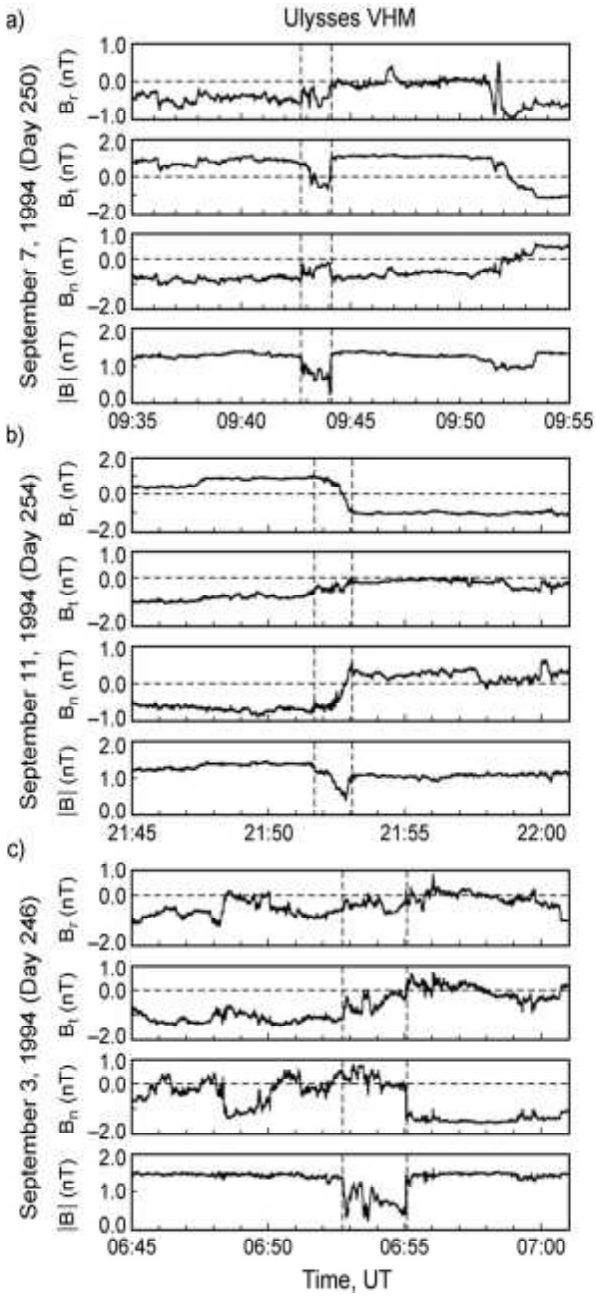
Fig. 2. Three examples of MDs in the Ulysses data. The field com- ponents are in heliospheric RTN coordinates.